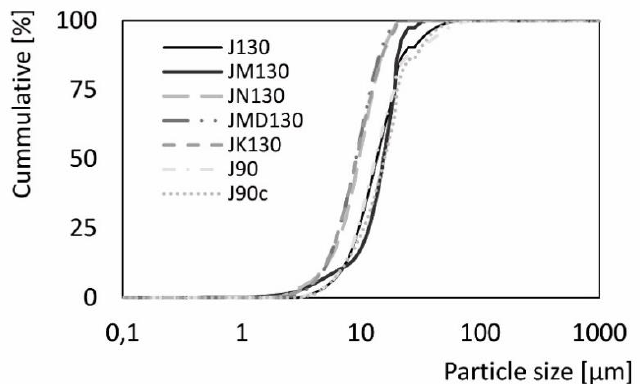
Figure 3. Cumulative particle size distribution of cloudy beetroot juice powders (abbreviations of variants explained in Table 1).